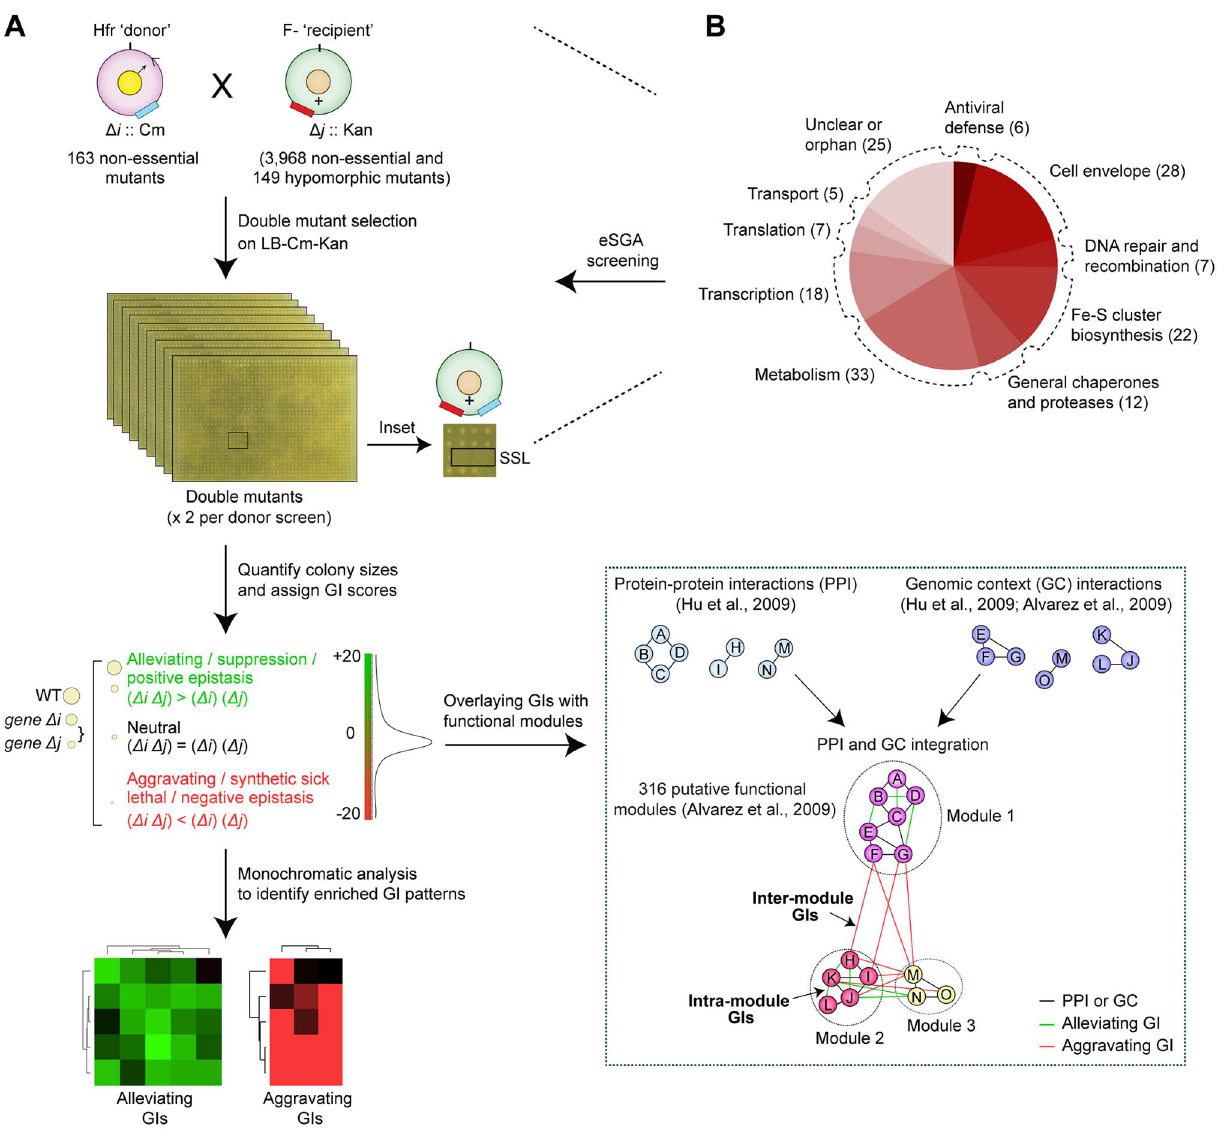
Figure 1. Target selection and eSGA screen pipeline. (A) Schematic showing conjugation-based double mutant construction, colony imaging, and fitness scoring [13,16]. The GIs were subjected to monochromatic analysis [45] to identify functionally related gene groups with similar GI patterns and overlaid with putative functional modules defined from PPI and GC-based networks [2,3]. (B) Bioprocess annotations and numbers (parenthesis) of functionally divergent query genes subjected to genome-wide eSGA